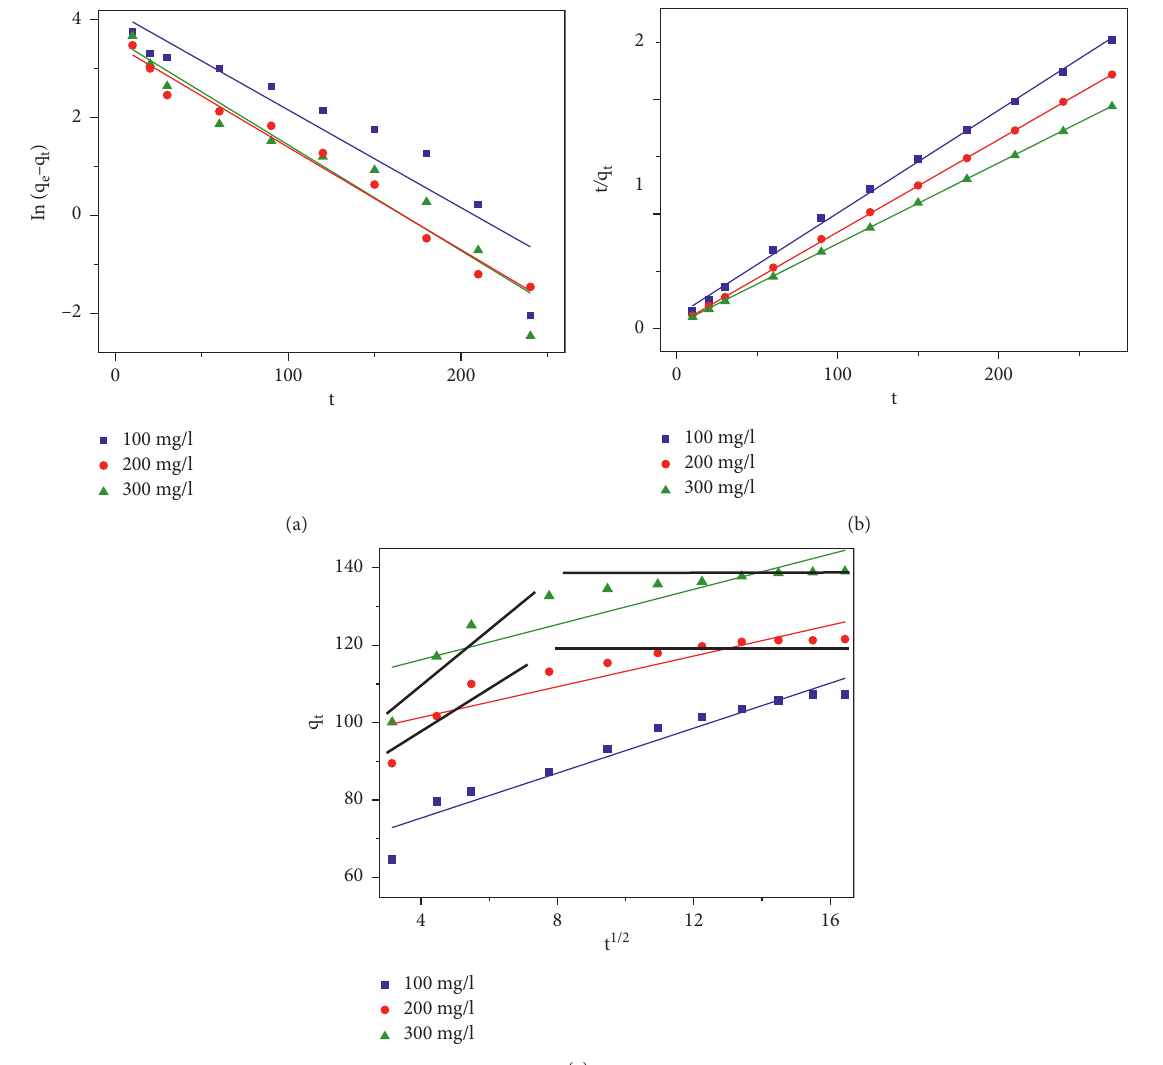
Figure 7: Kinetics of Cu(II) adsorption on PAC850-1-3: (a) pseudo first-order, (b) pseudo second-order, and (c) intraparticle diffusion model (PACs dose: 0.0500g; temperature: 30 ° C; pH: 5; volume of of Cu(II) solution: 200ml; concentration of Cu(II):100, 200 and